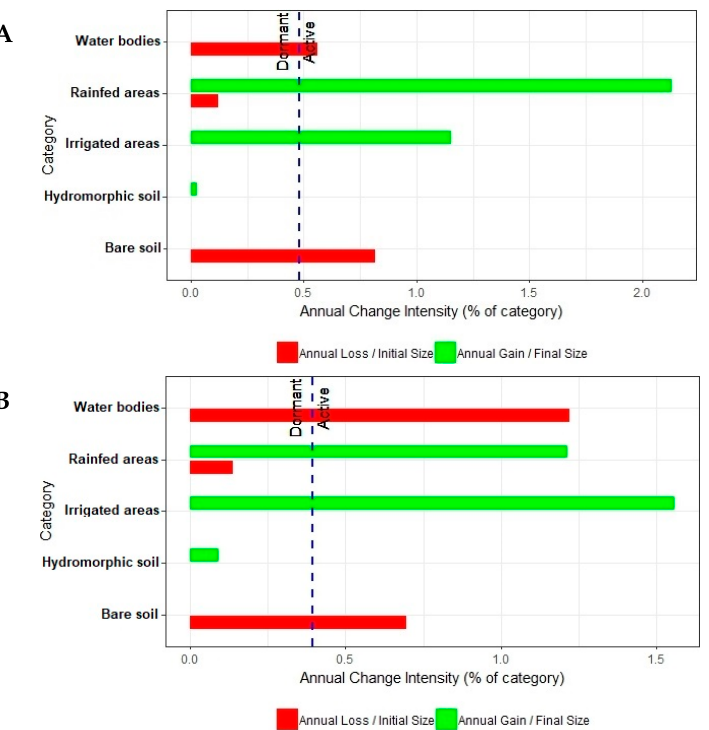
Figure 9. Annual change intensity for each of the LULC classes between the periods 1987–2000 ( A ) and 2000–2015 ( B ).